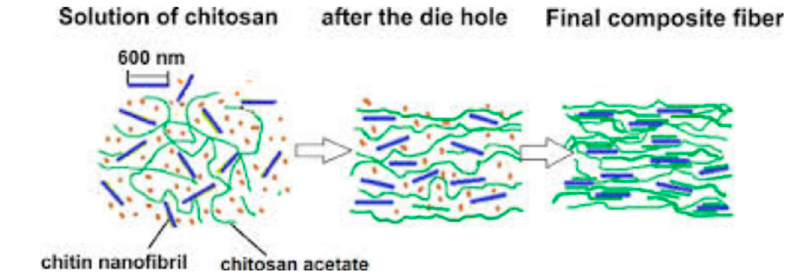
Figure 8. Nanocomposite structure organization made by chitosan fibers (green) and chitin nanofibrils (blue) [76].